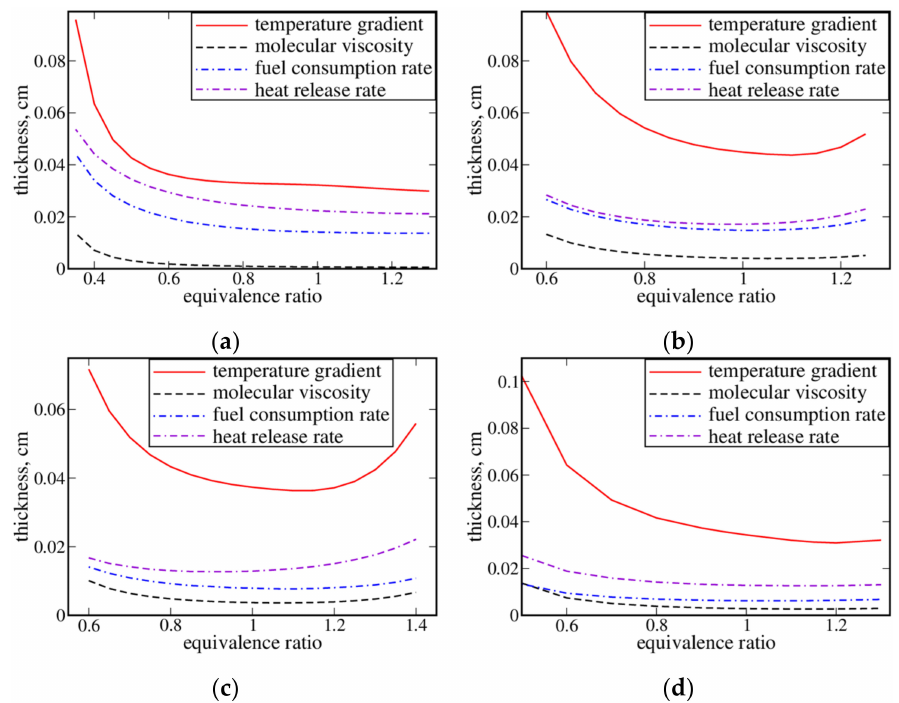
Figure 5. Dependencies of differently defined laminar flame thicknesses on the equivalence ratio, computed for ( a ) H 2 –air, ( b ) CH 4 –air, ( c ) C 3 H 8 –air, and ( d ) n -C 7 H 16 –air mixtures under room